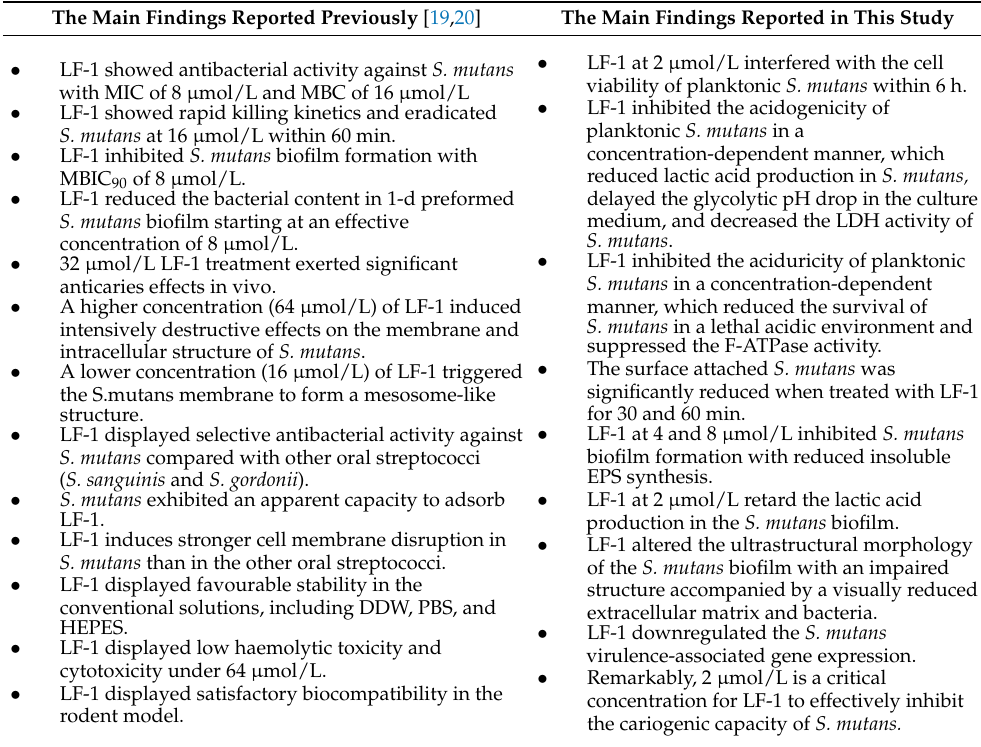
Table 1. A comparison between the main findings of LF-1 previously reported and those obtained in this